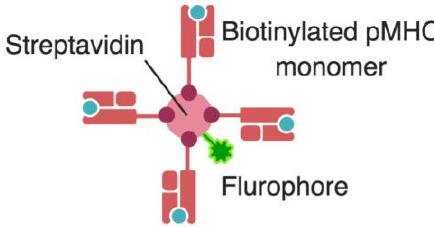
Figure 3. Tetramer design. A biotinylated MHC molecule is loaded with an epitope of known specificity that is optimally presented by this specific MHC allele. Four of these biotinylated pMHC molecules are tetramerized by binding them together with a streptavidin molecule bearing a fluorophore that could then be detected by flow cytometry. pMHC, peptide-MHC complex. * Created with BioRender.